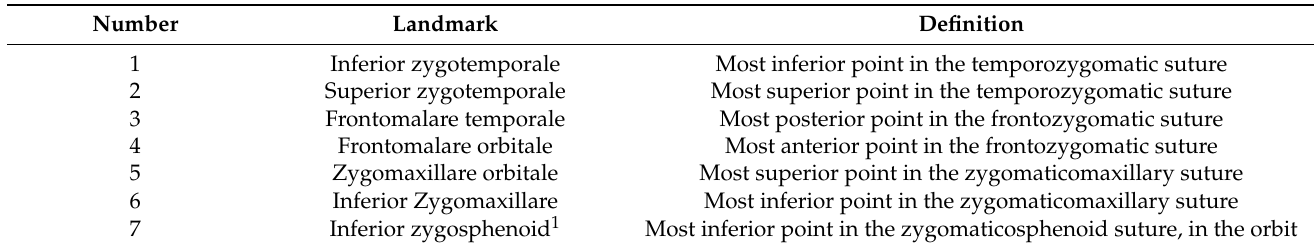
Table 2. Fixed landmarks used in this study